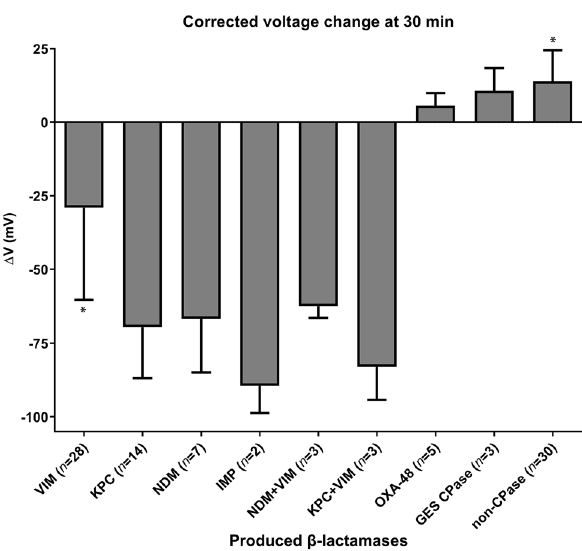
Figure 4. Voltage changes observed during 30 min measurements of the various laboratory and clinical strains assayed in this study grouped according to the β-lactamase type produced. NDM, IMP and KPC carbapenemase producing enterobacteria yielded the highest pH reductions while VIM strains exhibited mixed performance. The 30 min time window was not adequate to reveal imipenem hydrolysis by OXA-48 K . pneumoniae as the voltage changes were positive similarly with the producers of the weak imipinemases of the GES type (i.e. GES-5 and GES-6) and carbapenemase negative strains. Comparison between the VIM producing and the non-CPase data sets using unpaired t-test yielded a two-tailed p value < 0.0001